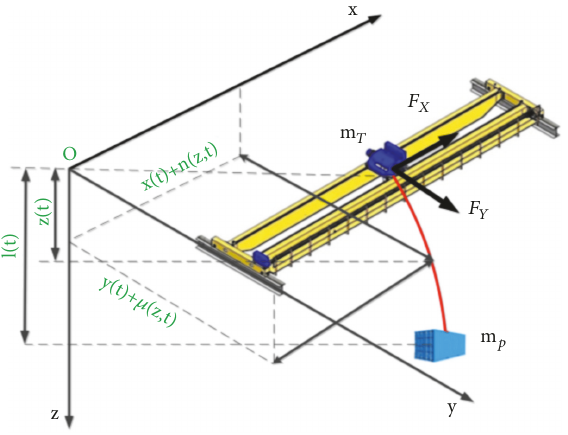
Figure 1: System